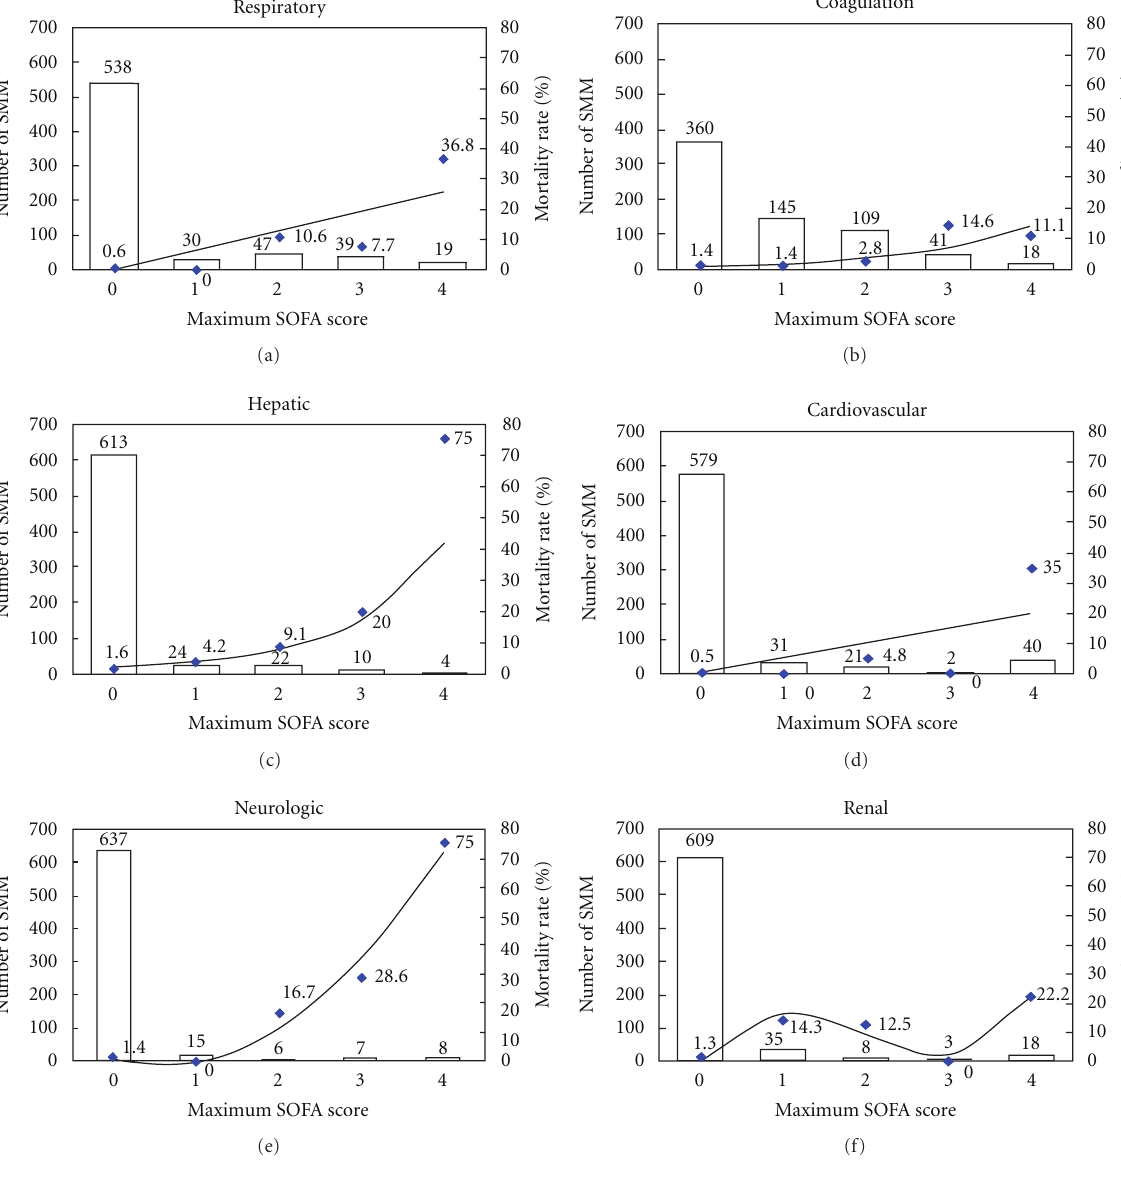
Figure 2: Number of Severe Maternal Morbidity (SMM) patients (bar), mortality rate (symbol) and regression adjustment of mortality, according to maximum Sequential Organ Failure Assessment (SOFA) score for each system